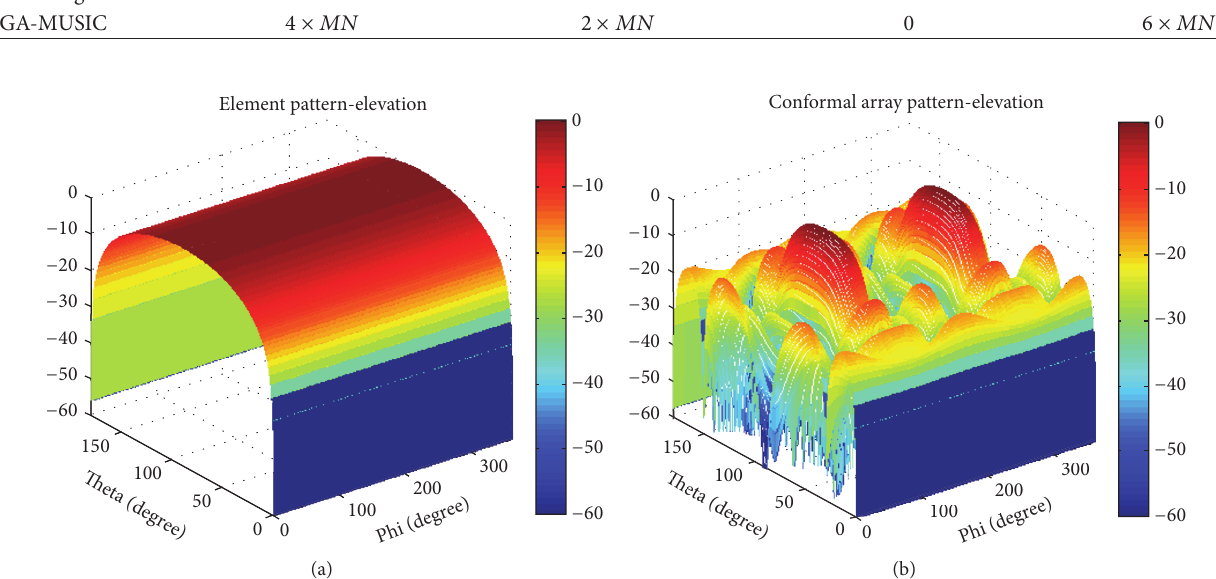
Figure 6: Pattern analysis: (a) pattern of single short dipole and (b) pattern of cylindrical conformal array.